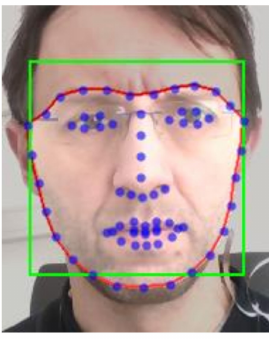
Figure 2. Example image frame with the region of interest (ROI)